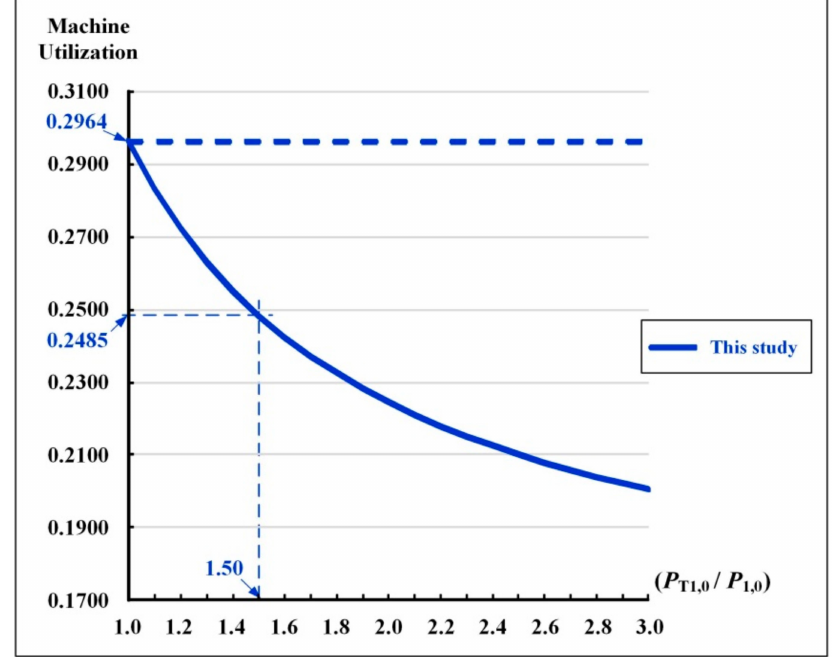
Figure 6. The influence of adjustable-rate ratio ( P T1,0 / P 1,0 ) on machine